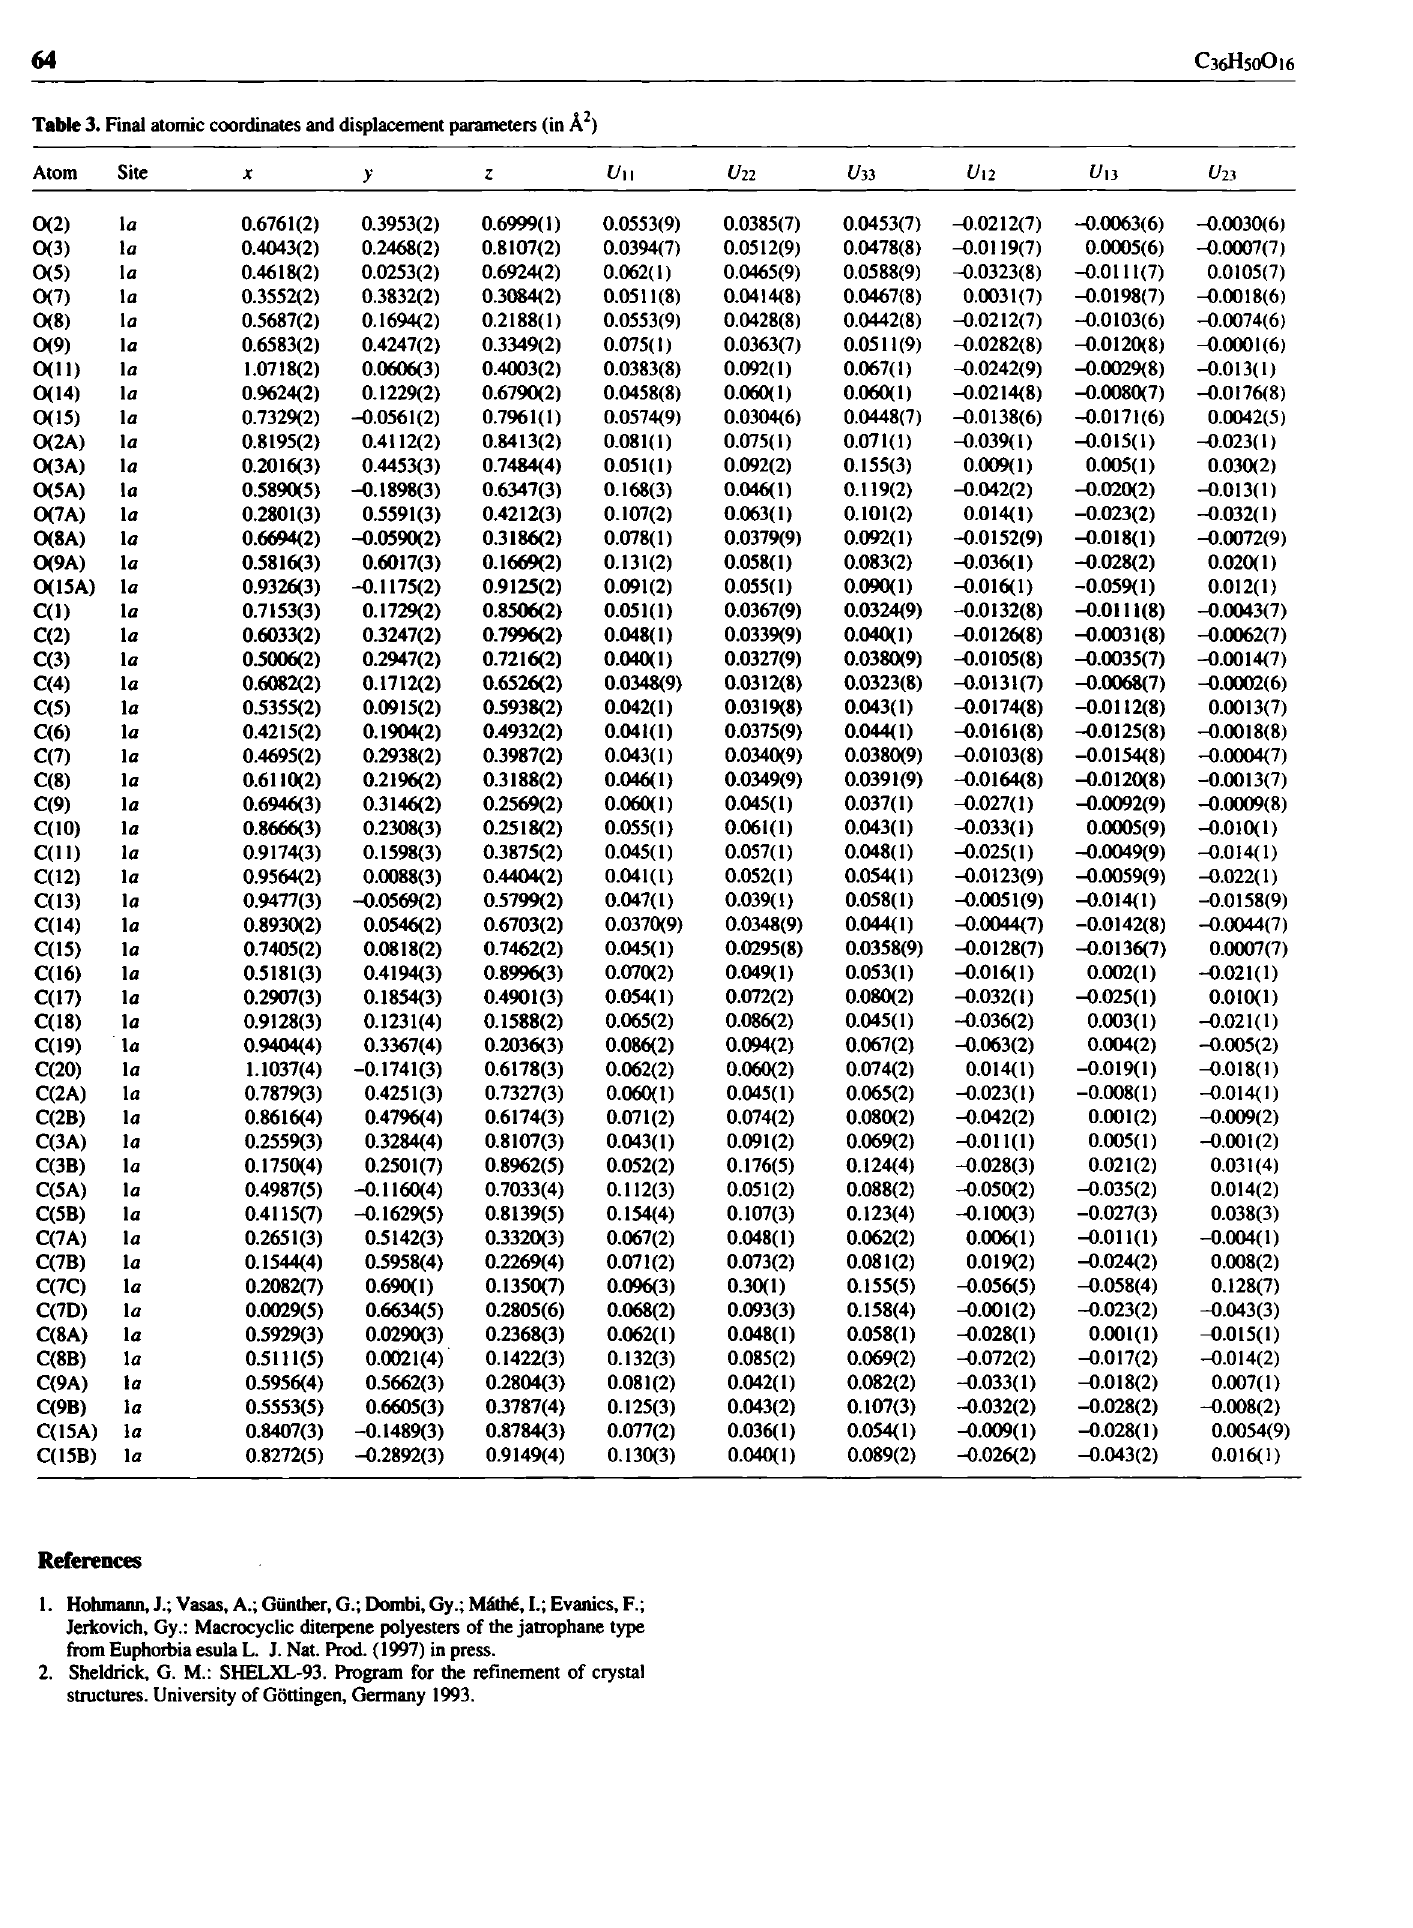
Table 3. Final atomic coordinates and displacement parameters (in À 2